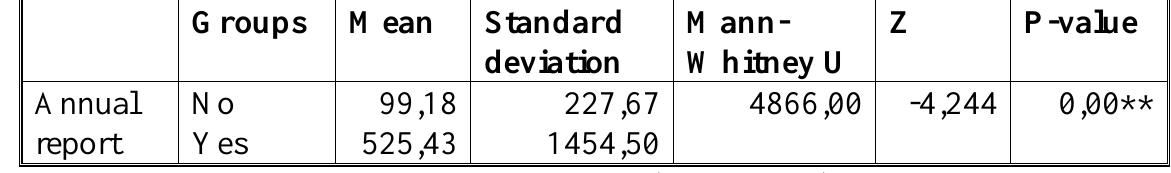
Testing of profitability against availability of digital annual reports using the Mann-Whitney Test Groups Mean Standard Mann- Z P-value deviation Whitney U Annual 99,18 report